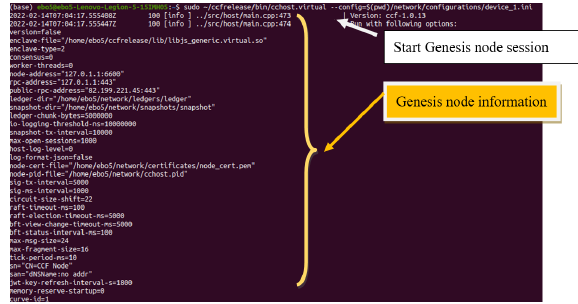
Fig. 2. node working under CCF environment